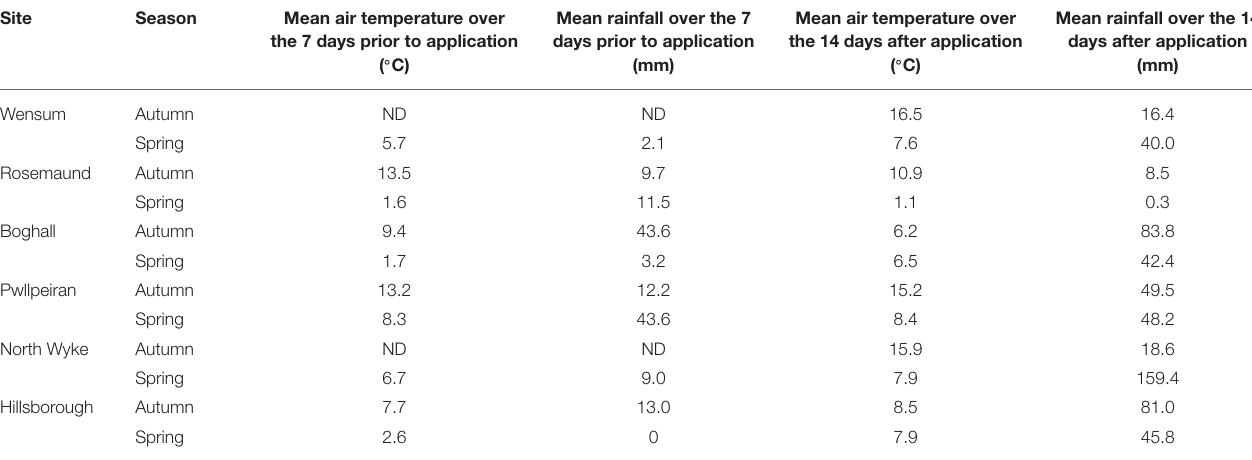
TABLE 3 | Weather data for the different sites and application timings.